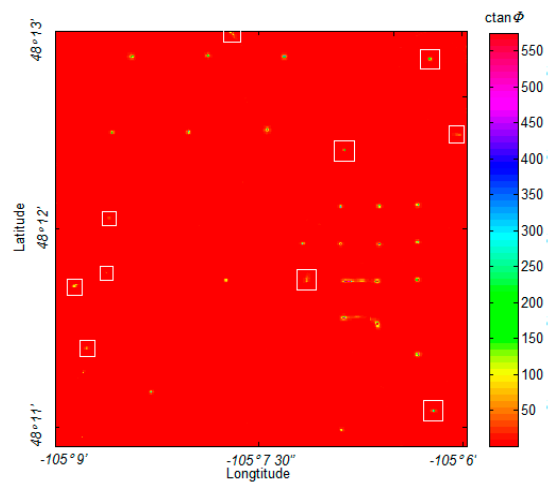
Figure 16. MDTA map marked with the detected weak anomalous sources, identified with a white rectangle.